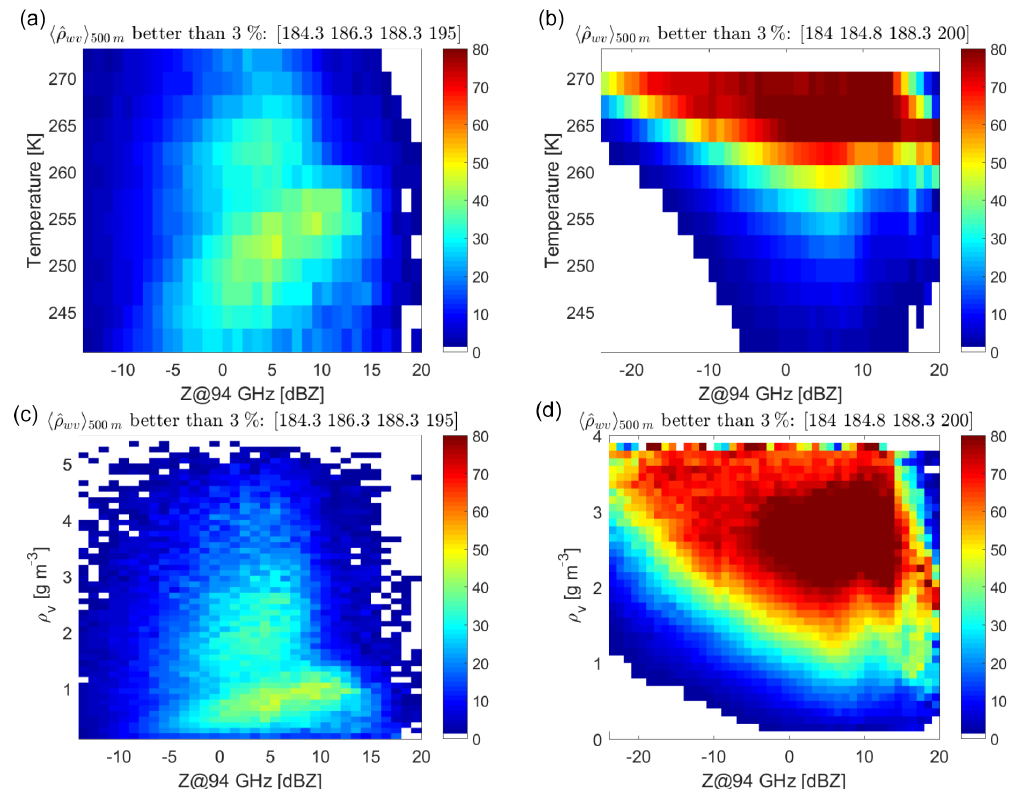
Figure 7. Statistical analysis based on 10d of CloudSat showing the expected frequency occurrence of retrievals of ρ v better than 3% for a space-borne system (a, c) and a ground-based system with ground temperature of 270K (b, d) . Results are clustered using reflectivities vs. temperatures (a, b) or water vapour contents (c, d) . The specifications of the systems correspond to four-tone DARs, which are optimized for ice cloud studies.